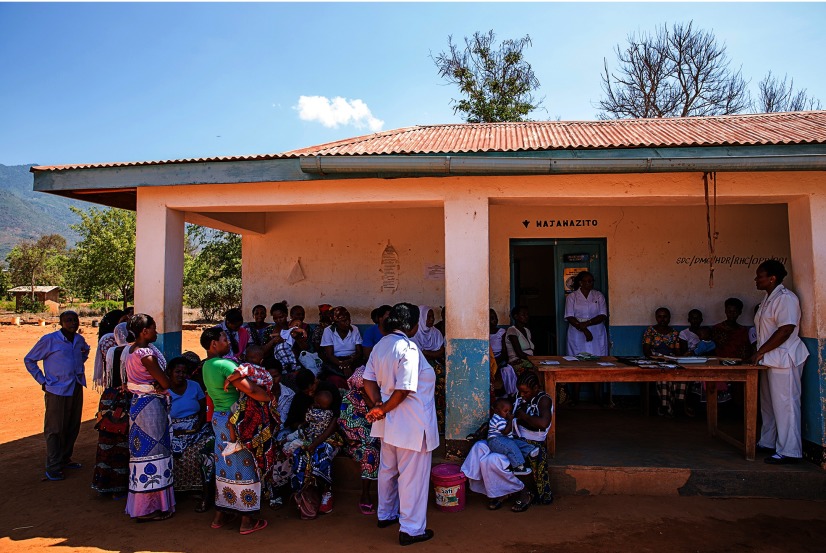
Clients of mobile outreach services in Tanzania listen to a group family planning counseling session. © 2015 Sala Lewis/EngenderHealth